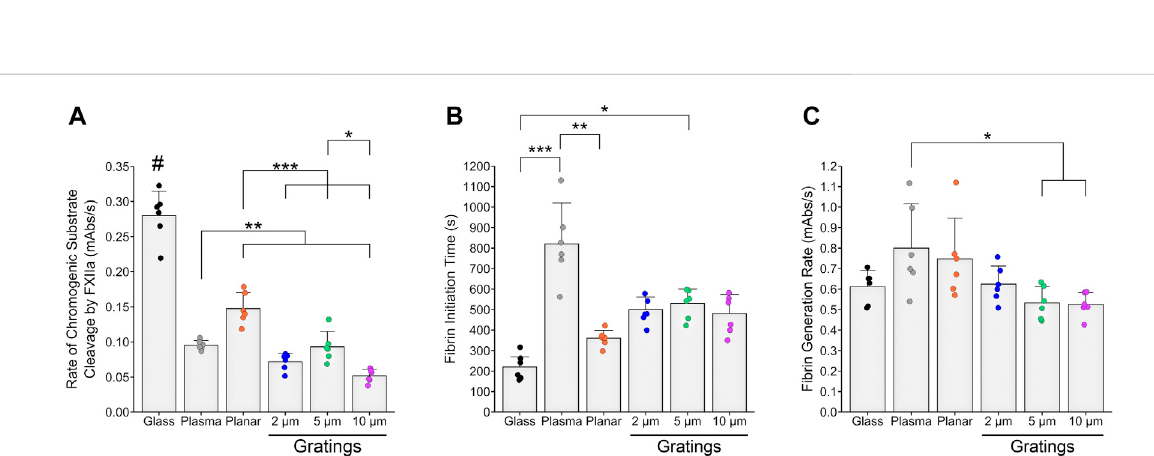
FIGURE 2 In vitro thrombogenicity of micropatterned PVA. Thrombogenicity of PVA samples was determined by FXIIa activity, fi brin initiation time, and fi brin generation rate using static in vitro assays compared to glass and plasma as positive and negative controls, respectively. (A) FXIIa activity measured by the rate of chromogenic substrate cleavage was signi fi cantly reduced for micropatterned PVA compared to planar PVA. FXIIa activity was signi fi cantly reduced for the 10 µm gratings compared to the 5 µm gratings. All groups had signi fi cantly reduced rate of chromogenic substrate cleavage by FXIIa compared to glass. Plasma was signi fi cantly different compared to planar PVA and 10 µm gratings. (B) No signi fi cant differences for the initiation time to fi brin formation were observed between planar PVA and micropatterned PVA gratings. We did observe a signi fi cantly prolonged initiation time to fi brin formation for 5 µm gratings compared to glass. Plasma had a signi fi cant increase in initiation time compared to planar PVA and glass due to adsorption of coagulation proteins to the PVA surface. (C) No signi fi cant differences between the rate of fi bringenerationwerefoundbetween PVAgroupsorglass. Plasmawasobserved tohaveasigni fi cantly increasedrateof fi bringenerationcompared tothe5and10 µmgratings.Samplesizecorrespondton=6foreachexperiment.*,**,and***indicate statistical signi fi cance ( p < 0.05, 0.01,0.001, respectively). # indicates statistical signi fi cance ( p < 0.0001) compared to all other experimental